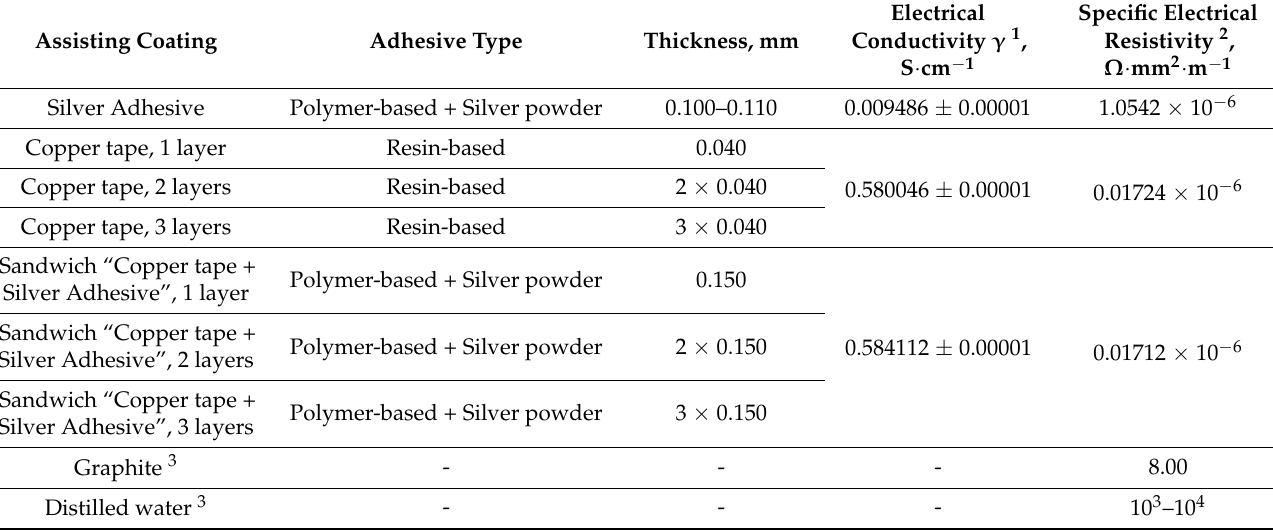
Table 4. Developed assisting coatings.